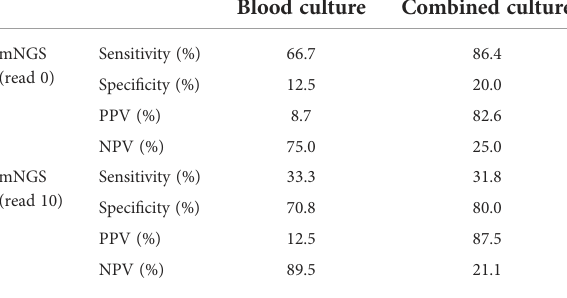
TABLE 2 Diagnostic performance of mNGS.